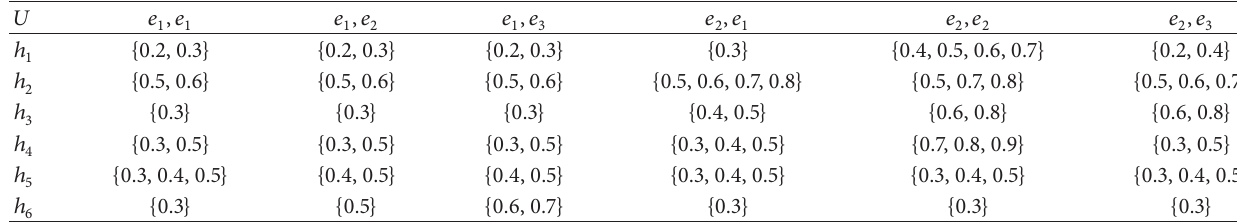
Table 4: The result of “AND” operation on